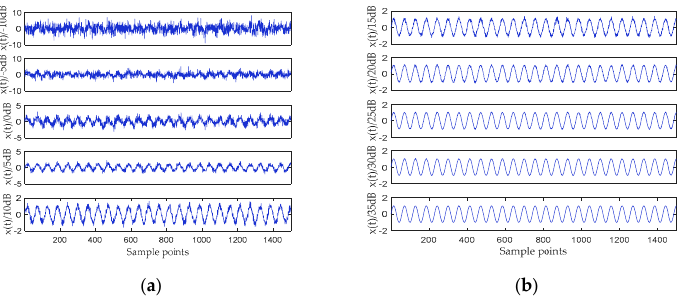
Figure 4. Time-domain waveforms of simulated signals with different signal-to-noise ratios (SNRs).